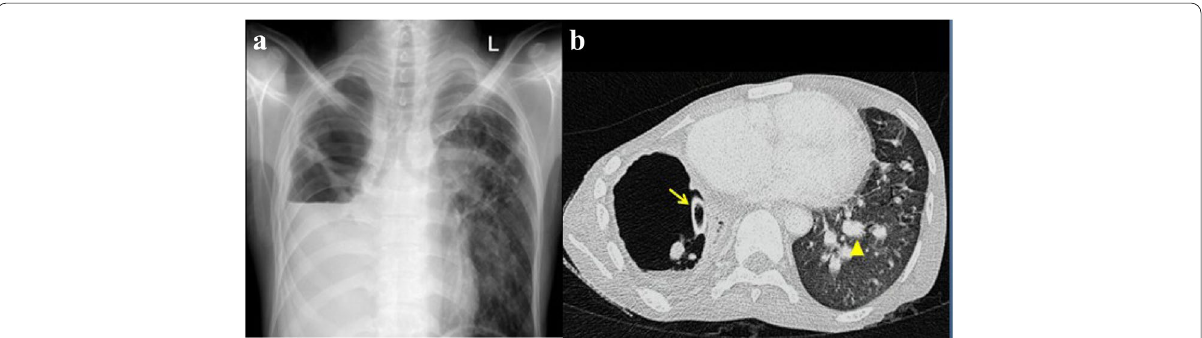
Fig. 1 a Chest radiograph (A-P) view showing volume loss on the right side with demarcated air fluid level, loss of broncho-vascular markings above the fluid, and collapsed underlying lung. There is silhouetting of right hilar shadow. Left lung field fibrotic opacities with cavitatory changes. b Contrast-enhanced computed tomography (CECT) chest shows the cicatricial collapse of the right lung with intercostal drainage inside right-sided cavitation with the presence of aspergilloma in the left apical region